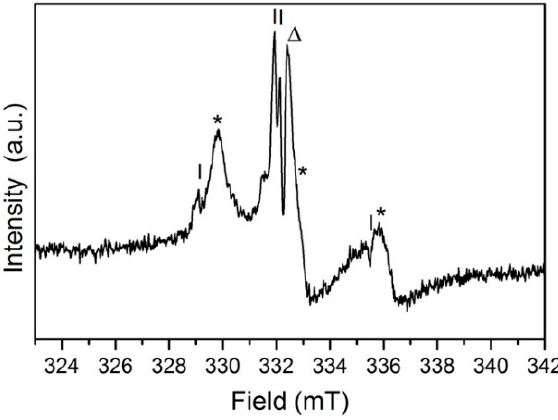
Figure 9. EPR signal for TiO 2 SG-400 recorded at 100K.